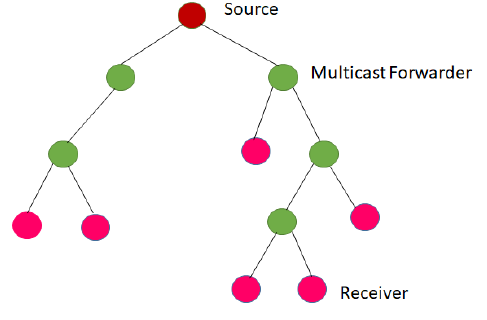
Figure 4 . Example Multicast